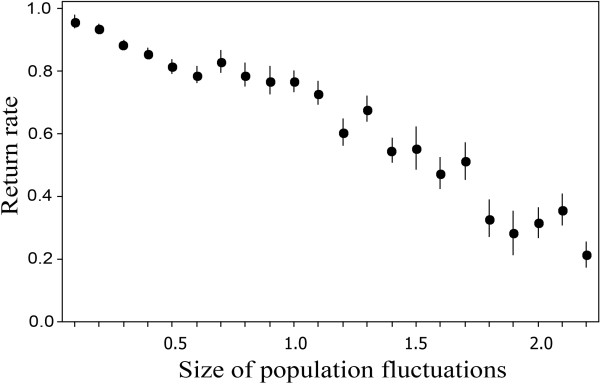
Return rate in voles in relation to the size of within-square population fluctuations. The size of population fluctuations within each square was assessed as maximum fold variation in population density [log10(Nmax/Nmin)]. Bars indicate standard errors.